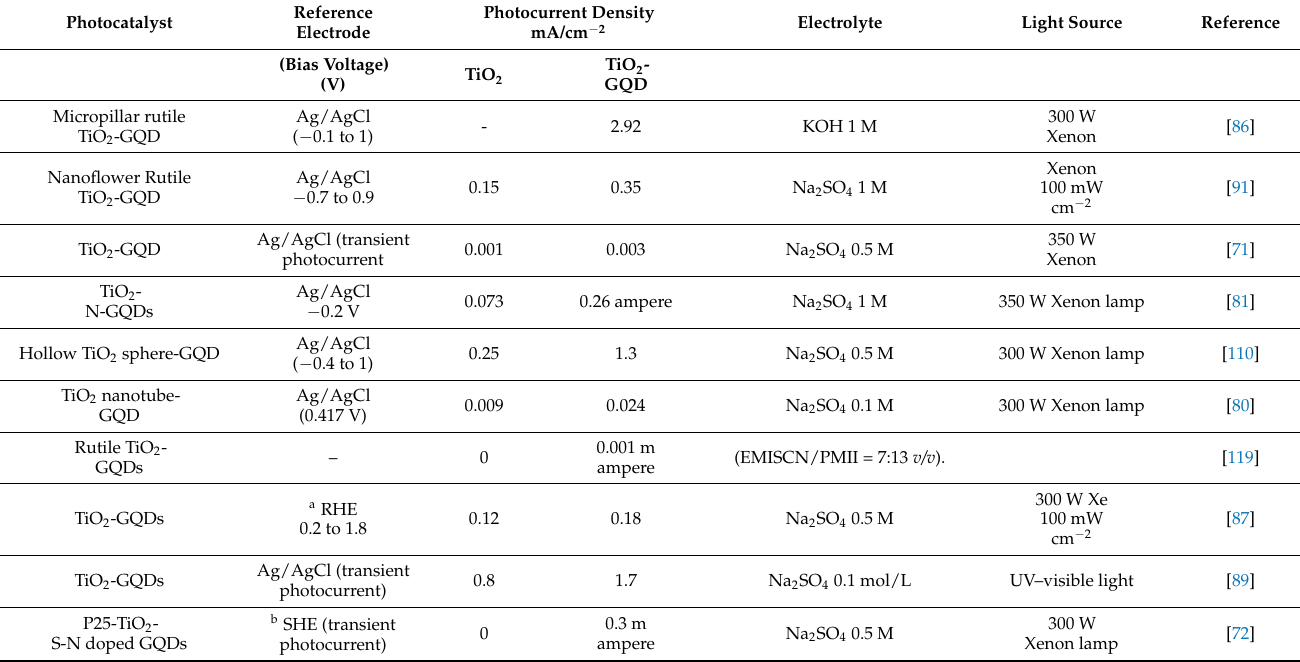
Table 3. TiO 2 -GQD nanocomposites used in PEC cells.